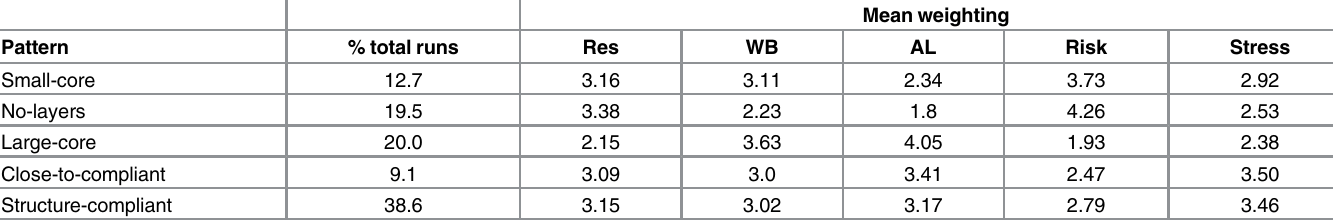
Table 6. Mean fitness weightings for each social structure pattern in the random initial condition (N = 300